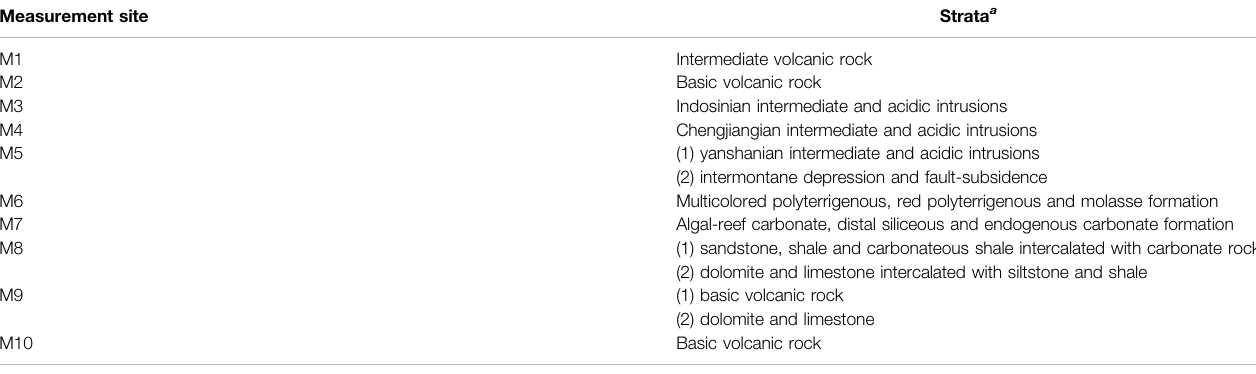
TABLE 4 | Strata of the measurement sites in the